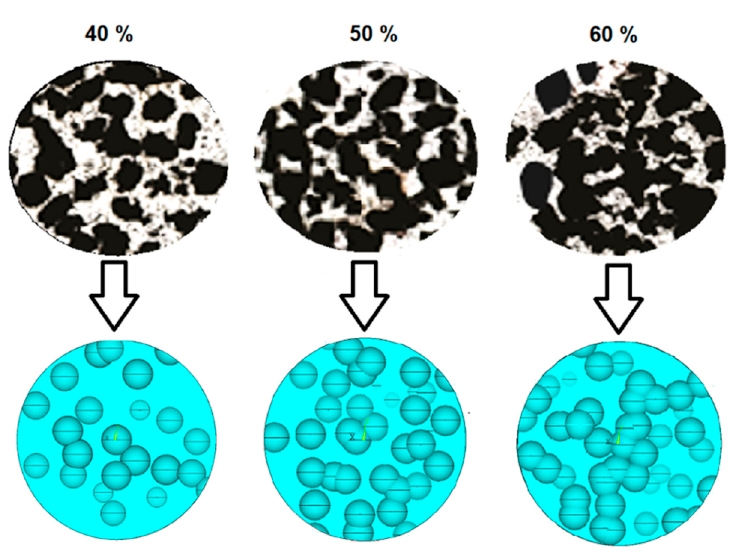
Figure 8. Comparison between cross section micrographs (up) and FEA modeled foams (bottom), for different foam porosities.